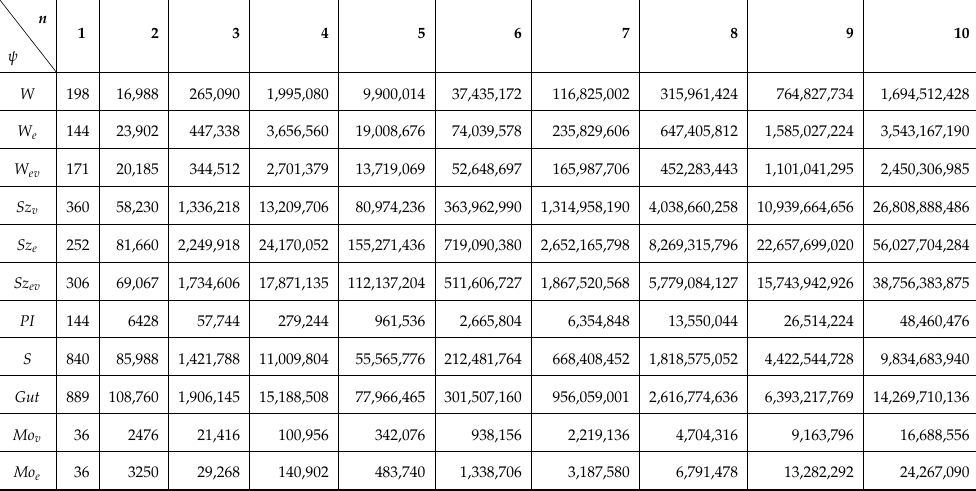
Table 5. Distance descriptors of wave-like nanoribbons WNR ( n , n , n ) .